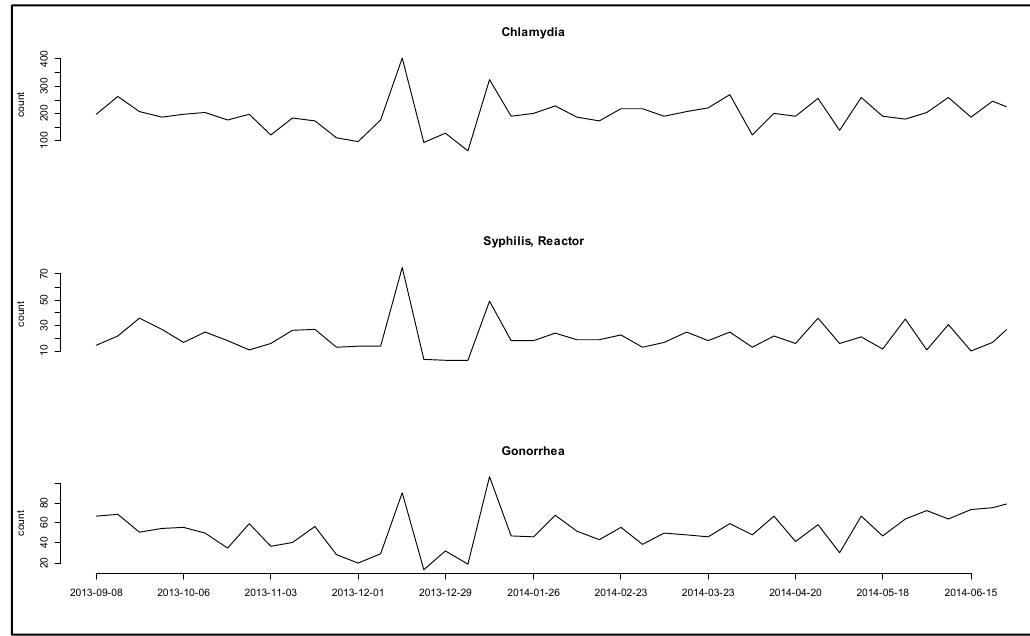
Figure 4. Counts of positive test results for chlamydia, syphilis reactor, and gonorrhea aggregated by week.